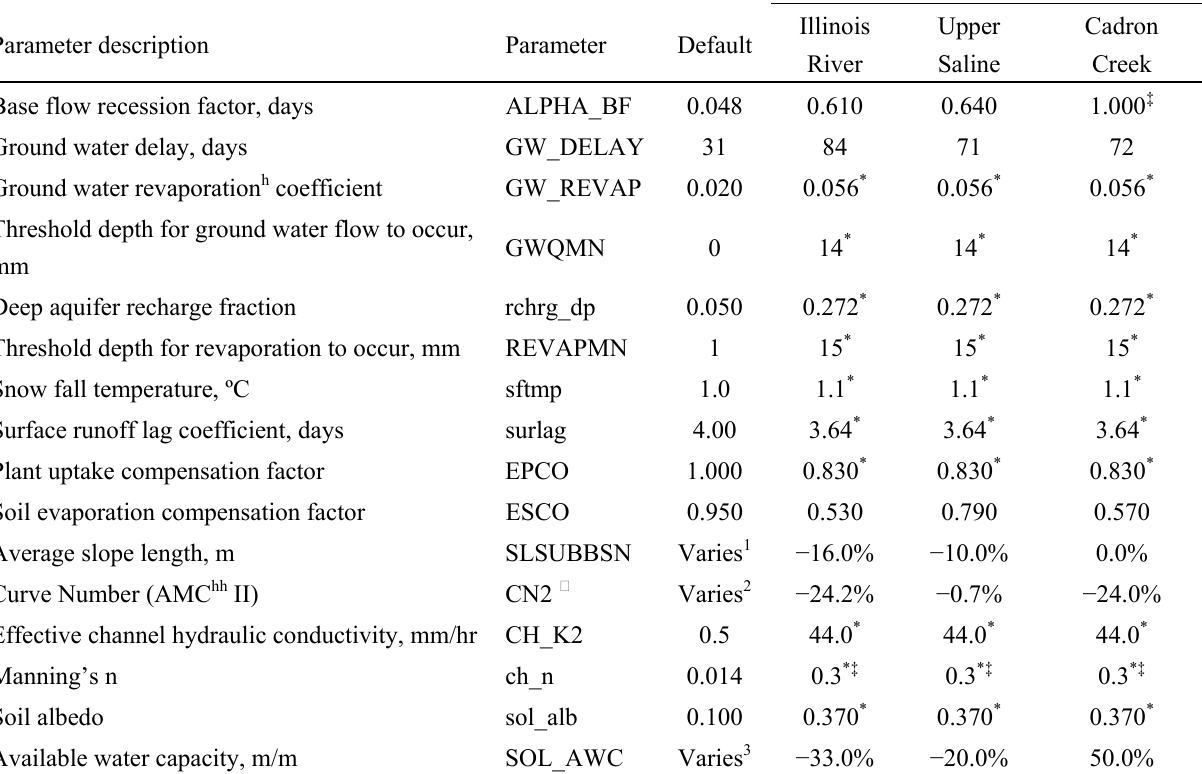
Regression-based